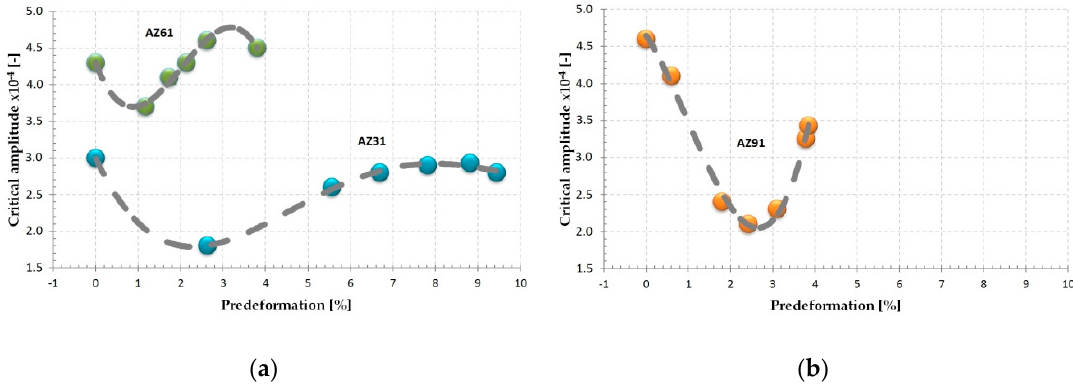
Figure 19. The critical amplitude, ε cr , depending on the predeformation step estimated for the ( a ) AZ31 and AZ61 alloys; ( b ) AZ91 alloy.